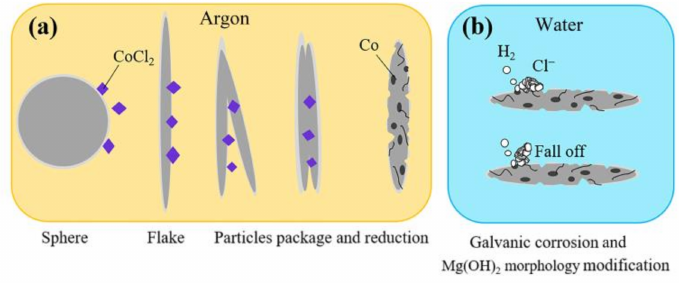
Figure 12. The activation mechanism, ( a ) ball milling process, ( b ) hydrolysis